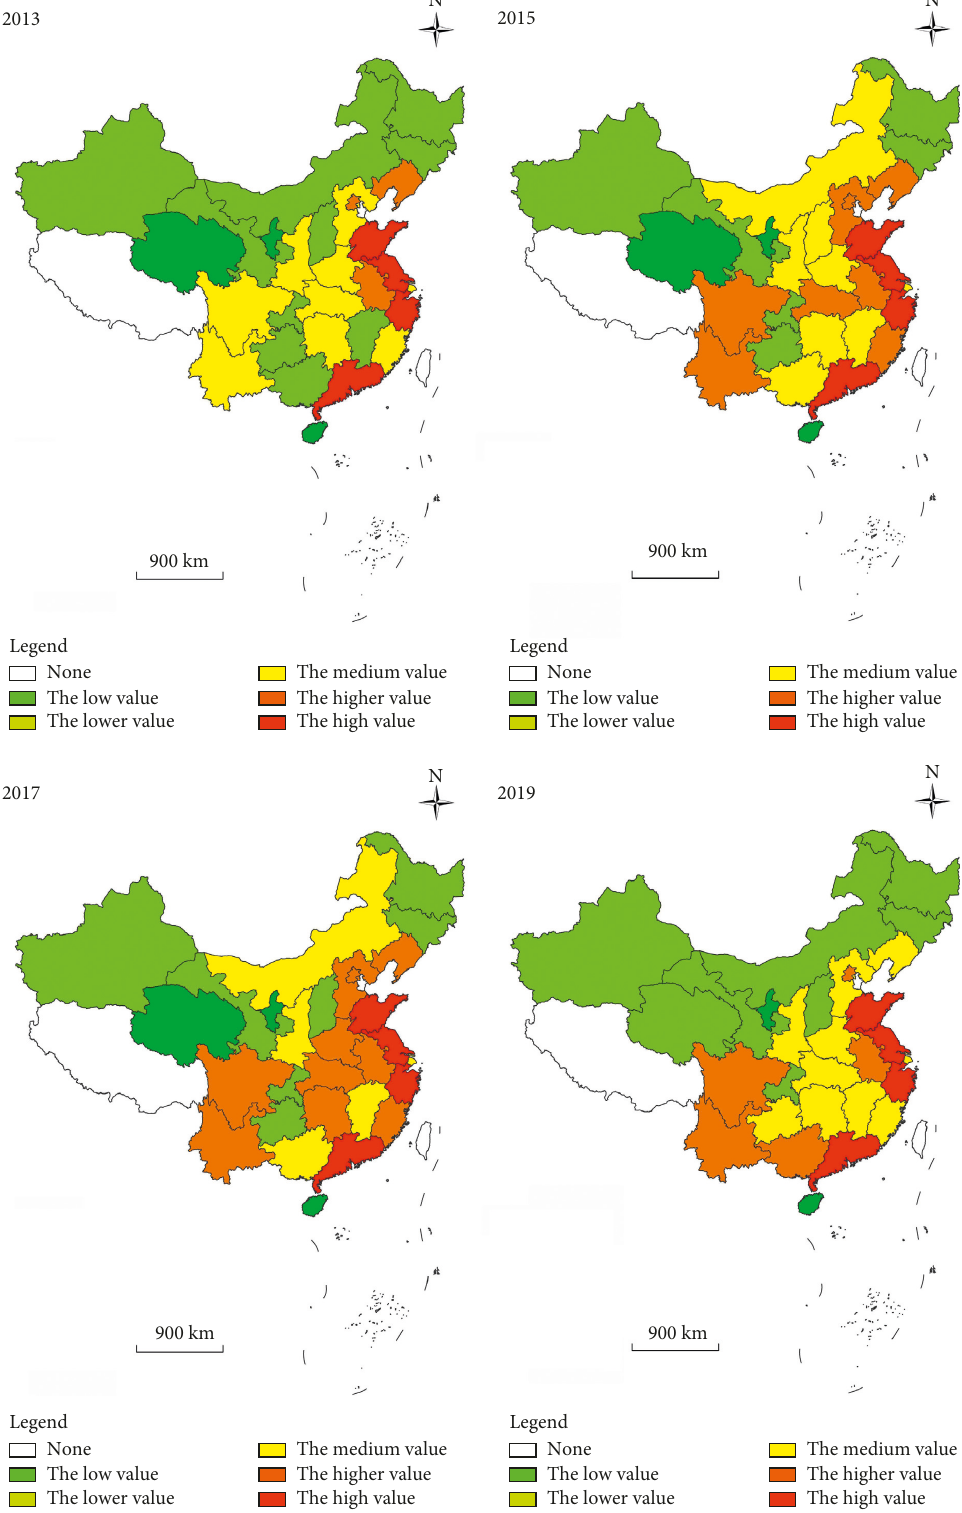
Figure 2: 2013–2019 provincial tourism industry development